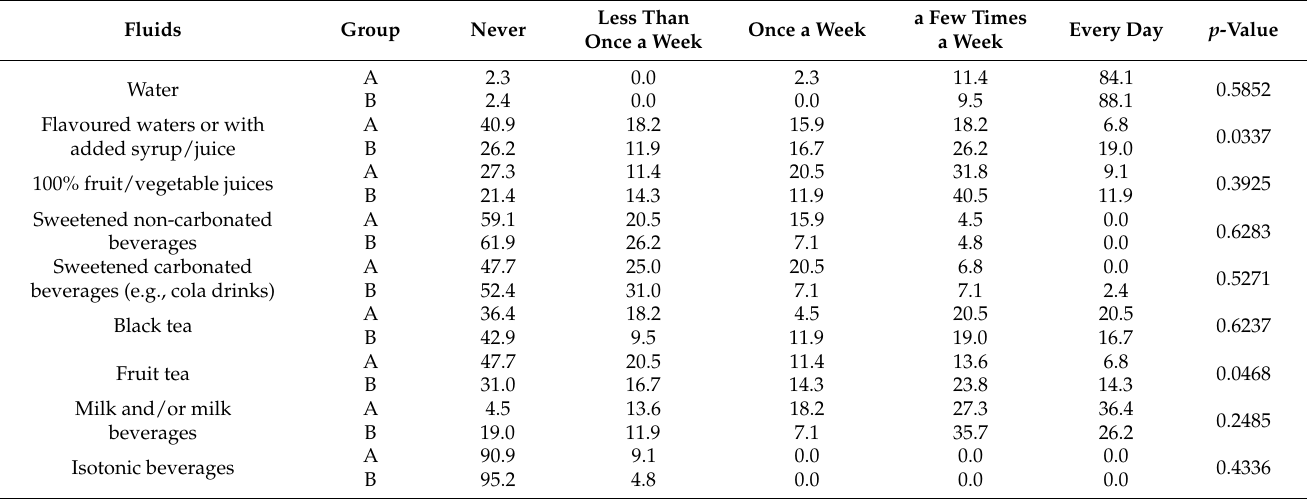
Table 3. Frequency of consumption (% of answers) of specific beverages, taking into account healthy and disabled